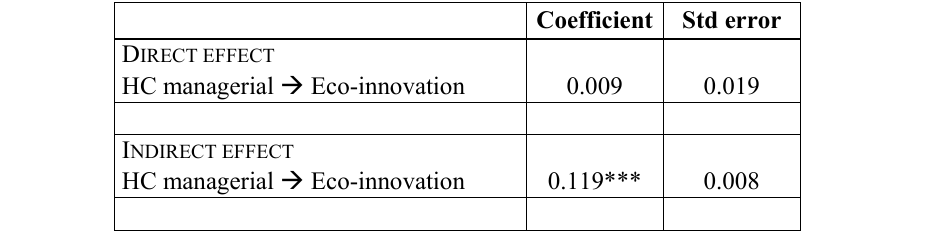
Table 4: Direct, Indirect, and Total Effects of HC Managerial on